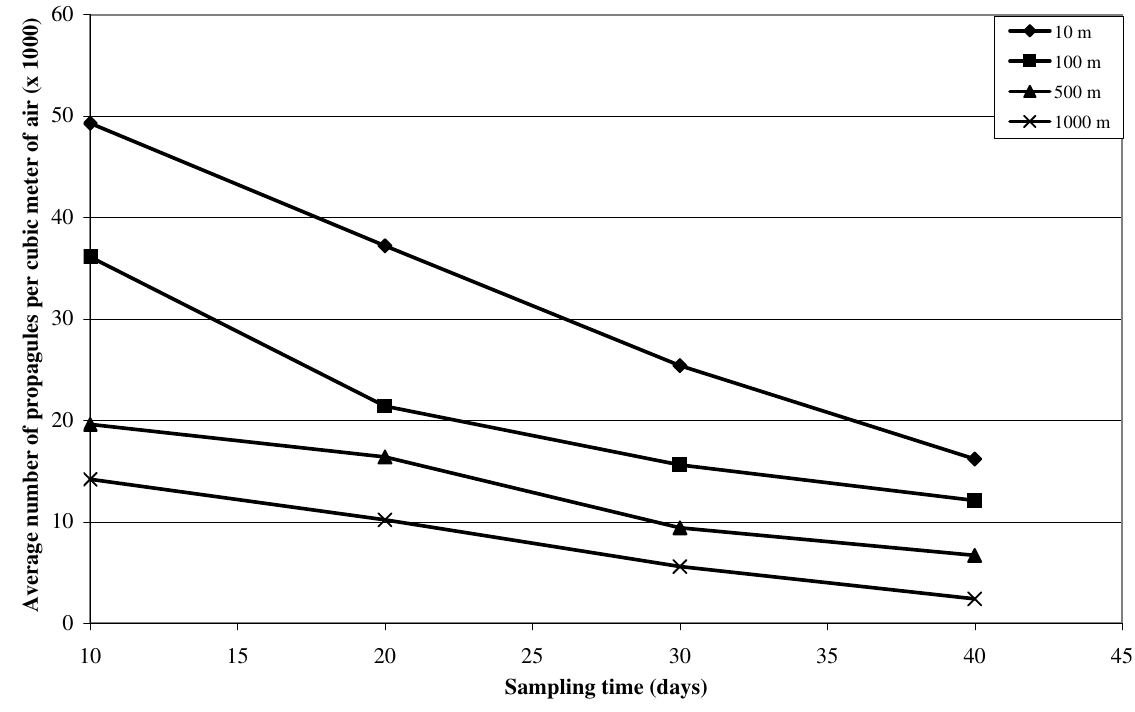
Fig. 2. Average number of Apiognomonia quercina propagules (ascospores and conidia) recorded in 2004 and 2005 per m 3 of air (×1000) in relation to distance from the inoculum